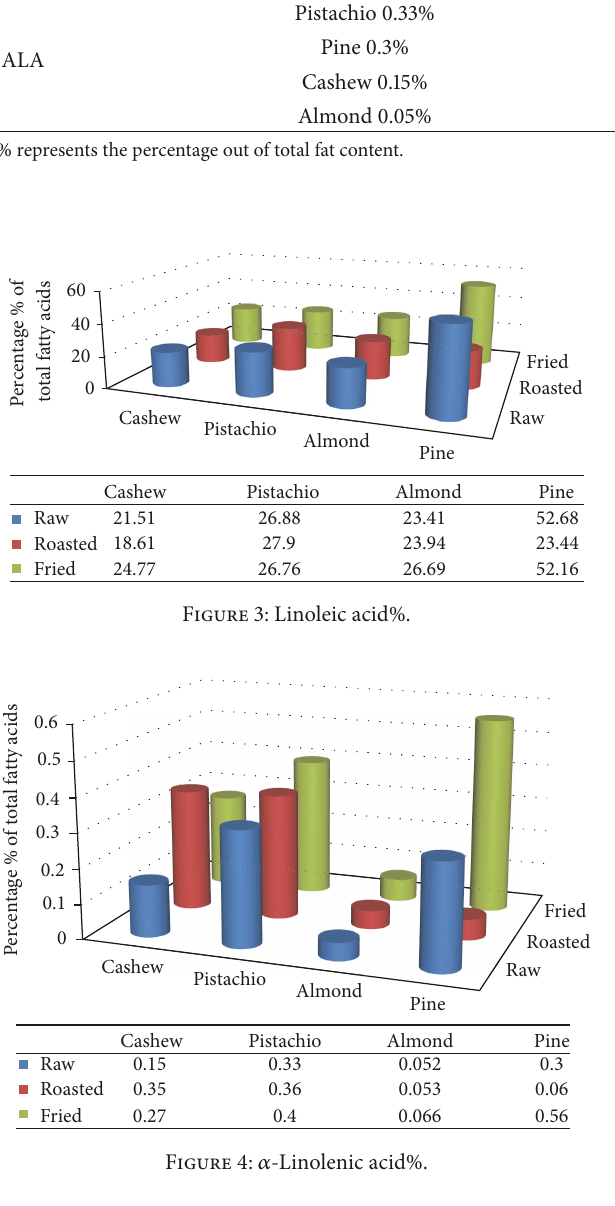
Figure 4: 𝛼 -Linolenic